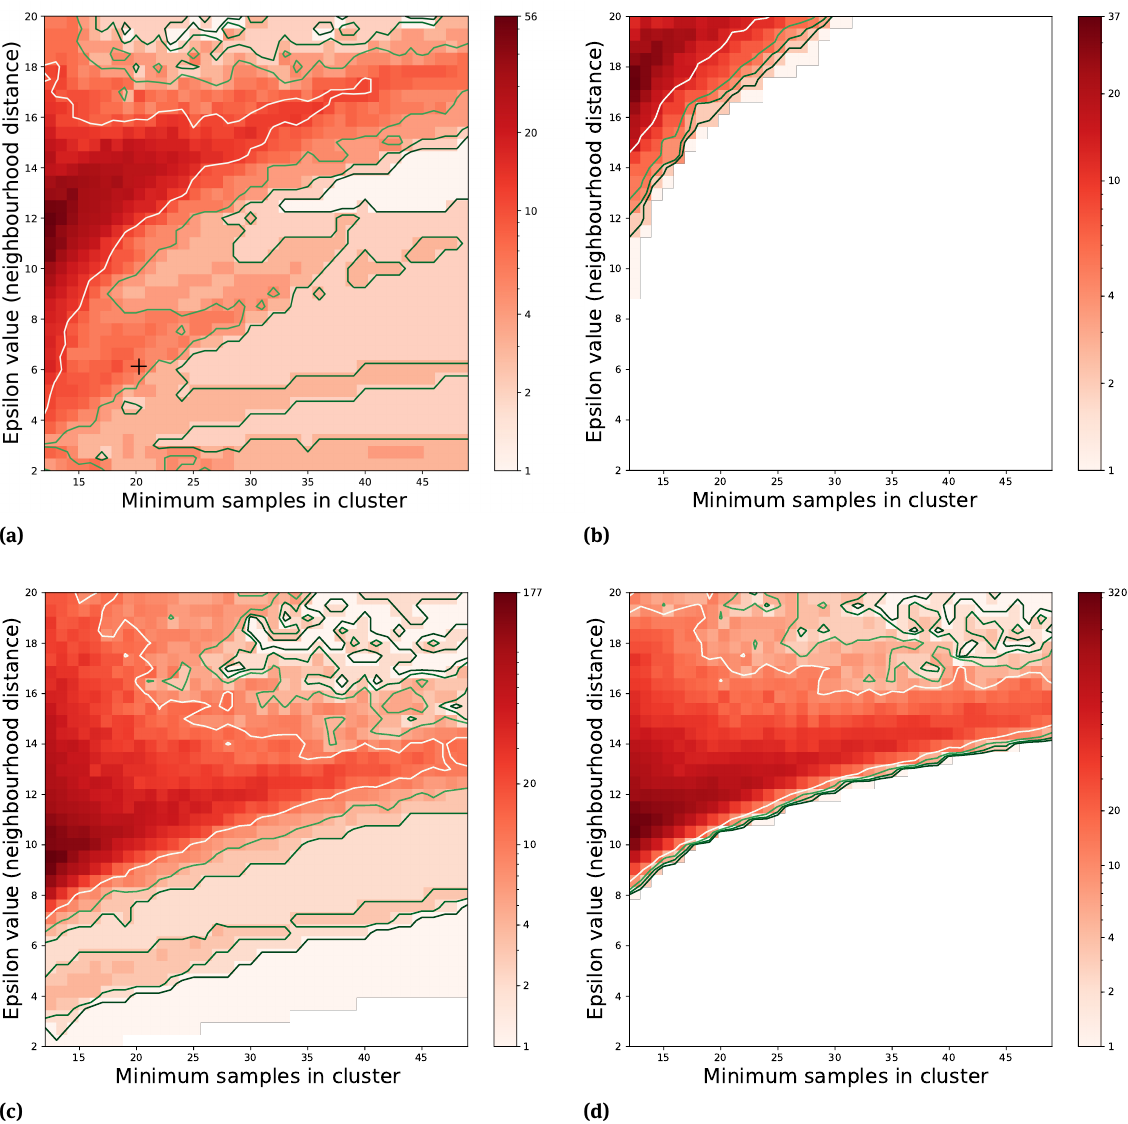
Figure 3. Dependency of amount of clusters labelled by DBSCAN on the clustering parameters for real (left) and model (right) data, for clustering of pairs (top) and stars directly (bottom). Amount of clusters labelled is shown with color gradient, green-to-white isolines designate areas with >1, >2, >4 and >10 clusters. Parameter value areas which produce clustering in model data are treated as the ones prone to creating false positives. It is therefore concluded that parameters of clustering should fit below area of false-positives, but in the region where real data does produce clusters. It can be seen that this suitable region is larger for the pairs data (compared to direct clustering of stars). The real pairs clustering parameters elected for further use are marked by black cross on the corresponding (top-left)